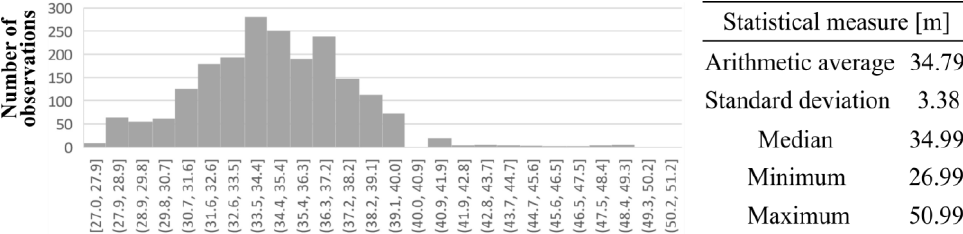
Figure 16. A histogram of error distribution for height determination by the satellite compass with the sample statistical parameters.